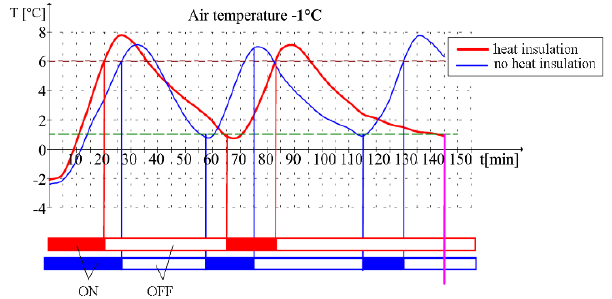
Figure 20. Temperature of stock-rail web for the control system in RH at the ambient temperature T = −1 °C; ( a ) with heat insulations and ( b ) without heat insulation [3].